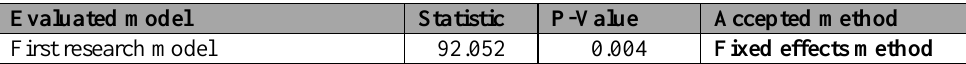
Table 8. Hausman test results for the first research model